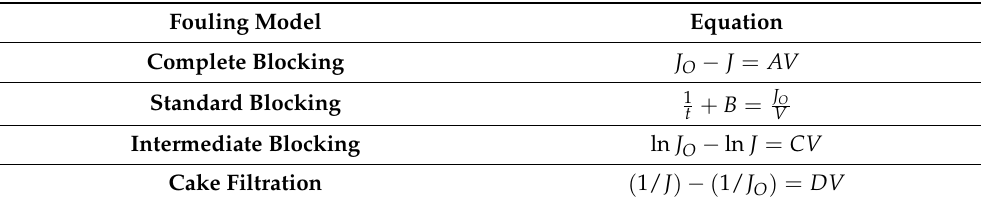
Table 1. Equations for different fouling mechanisms. Fouling Model